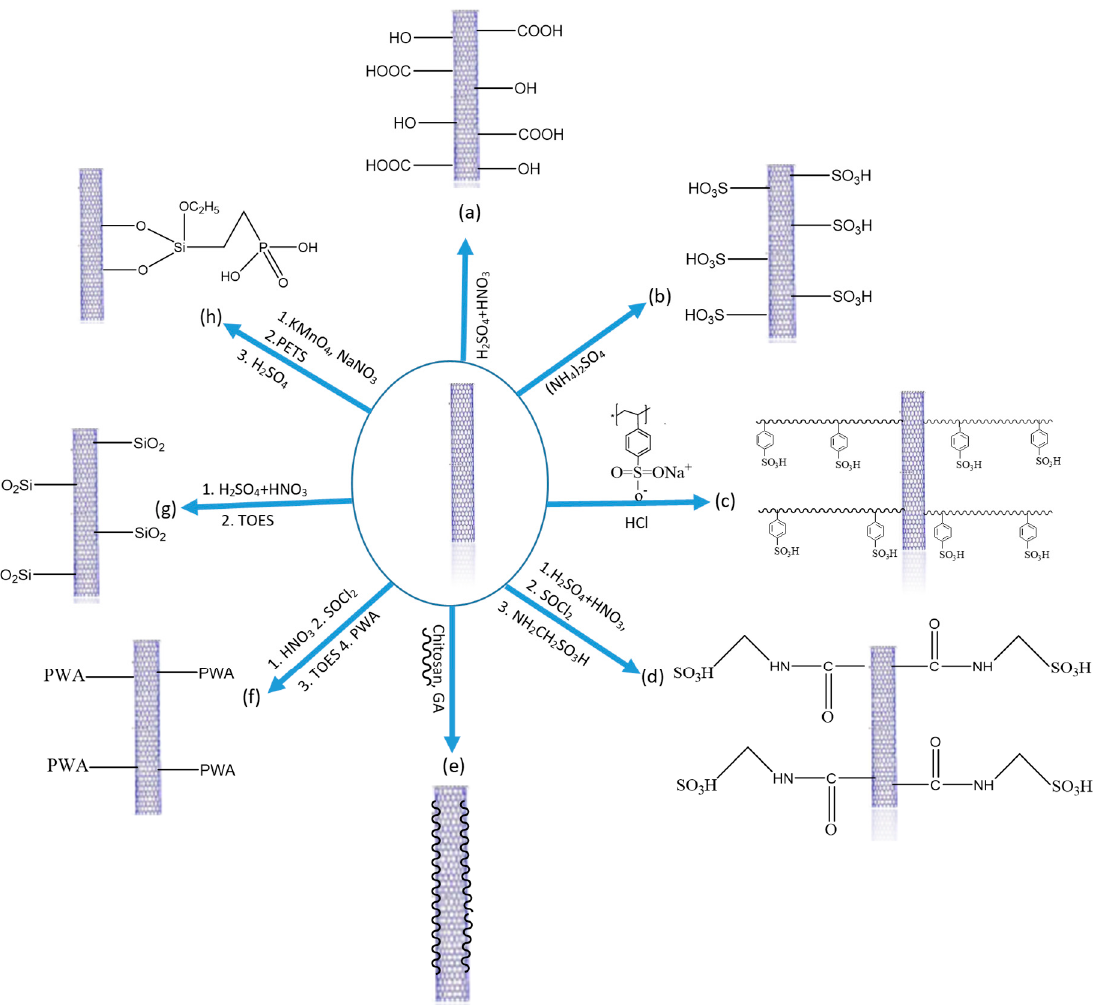
Figure 6. Different functionalization approaches for CNTs using ( a ) carboxylic acid, ( b ) sulfonic acid ( c ) PSSA, ( d ) aminomethanesulfonic acid, ( e ) chitosan, ( f ) phosphotungstic acid ( g ) silica and ( h ) phosphonic acid groups.